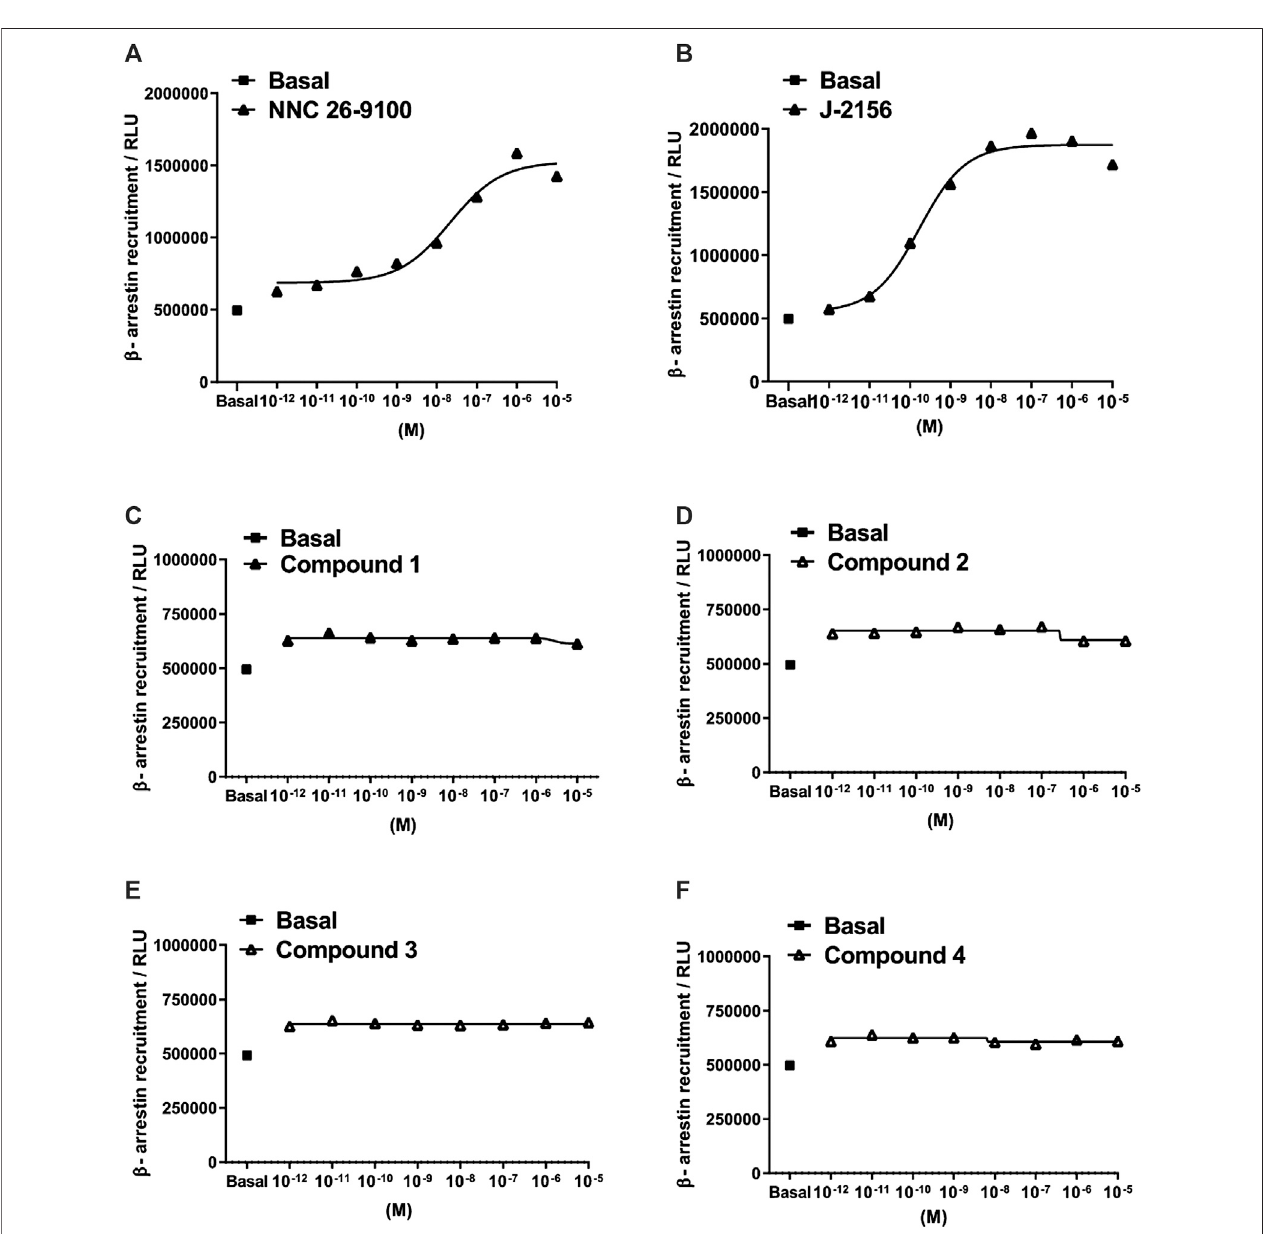
FIGURE 4 | Concentration-response curves of Compounds 1 – 4 in the β -arrestin 2 recruitment assay. Data represent concentration – response curves of the novel compounds expressed as relative luminescence units (RLU) in comparison to the reference compounds NNC 26-9100 and J-2156. All values are means ± SEM ( n (cid:2) 2 experiments). In each experiment, data points were obtained in